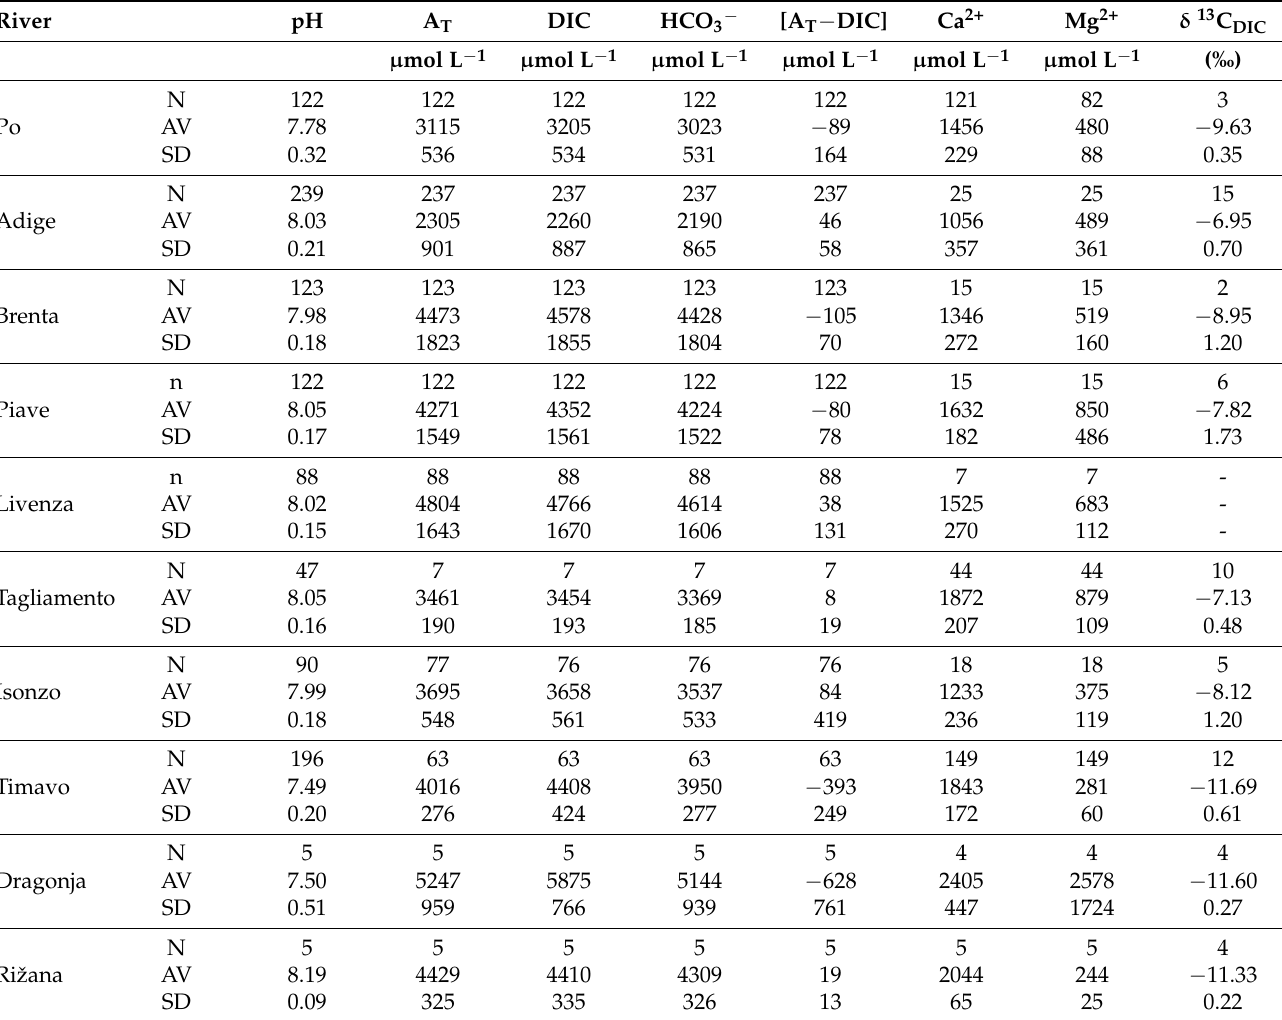
Table 1. Descriptive statistics of the parameters measured in the river waters (data in Table S1, since the 2000s): number of data (N), mean (AV) and standard deviation